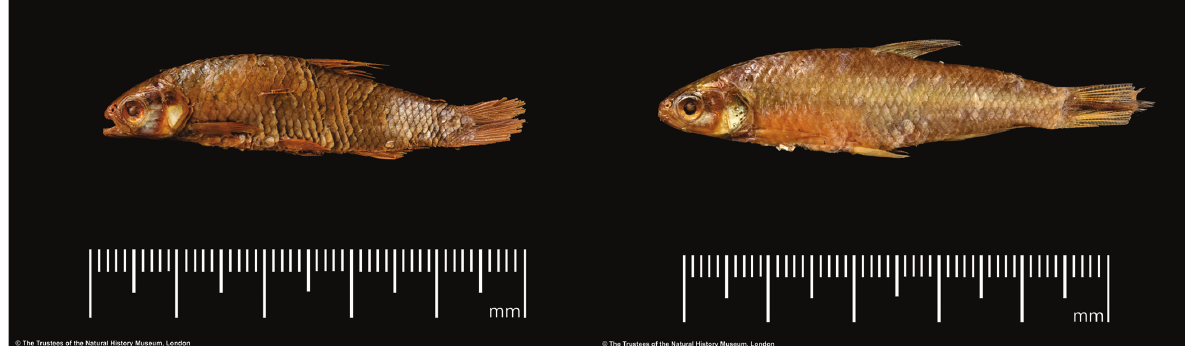
Figure 1. Syntypes of Aphyocharax pusillus : BMNH 1867.6.13.58-59. Photographed by Kevin Webb.